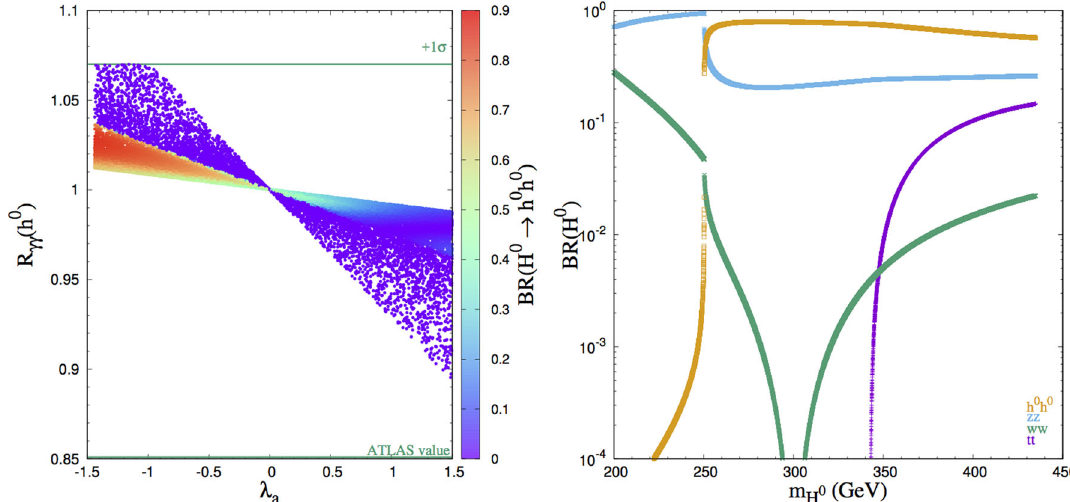
Fig. 4 BR ( H 0 → h 0 h 0 ) variation in the ( R γγ ( h 0 ) , λ a ) plane taking into account ATLAS result at 1 σ , with the following inputs: λ ≈ 0 . 52, | λ